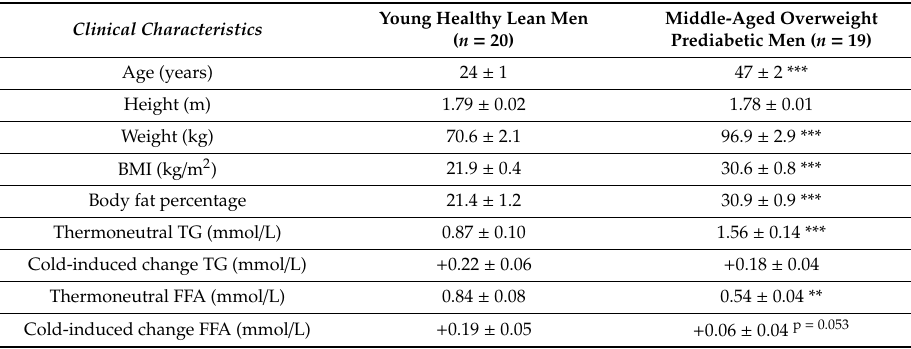
Table 1. Clinical characteristics. Data are mean ± SEM. *** p < 0.001, ** p < 0.01 middle-aged overweight prediabetic men vs. young, healthy, lean men. BMI = body mass index, FFA = free fatty acids, TG = triglycerides. Four healthy, young, lean subjects and one middle-aged overweight subject were excluded from the original cohorts due to absent plasma